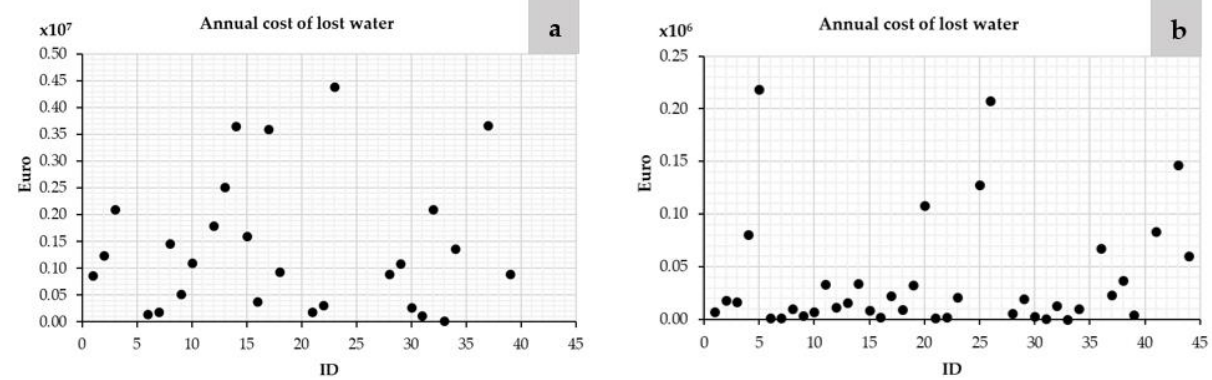
Figure 6. The annual cost of lost water ( a ) and the annual cost of lost water ( b ). The leak calculation methods such as BABE, MNF, and water balance were applied and compared in different case studies, which were defined by [117,118]. The analysis was established to determine the real water loss in million m 3 /year as shown in Table 8. Table 8. Leak method comparison.